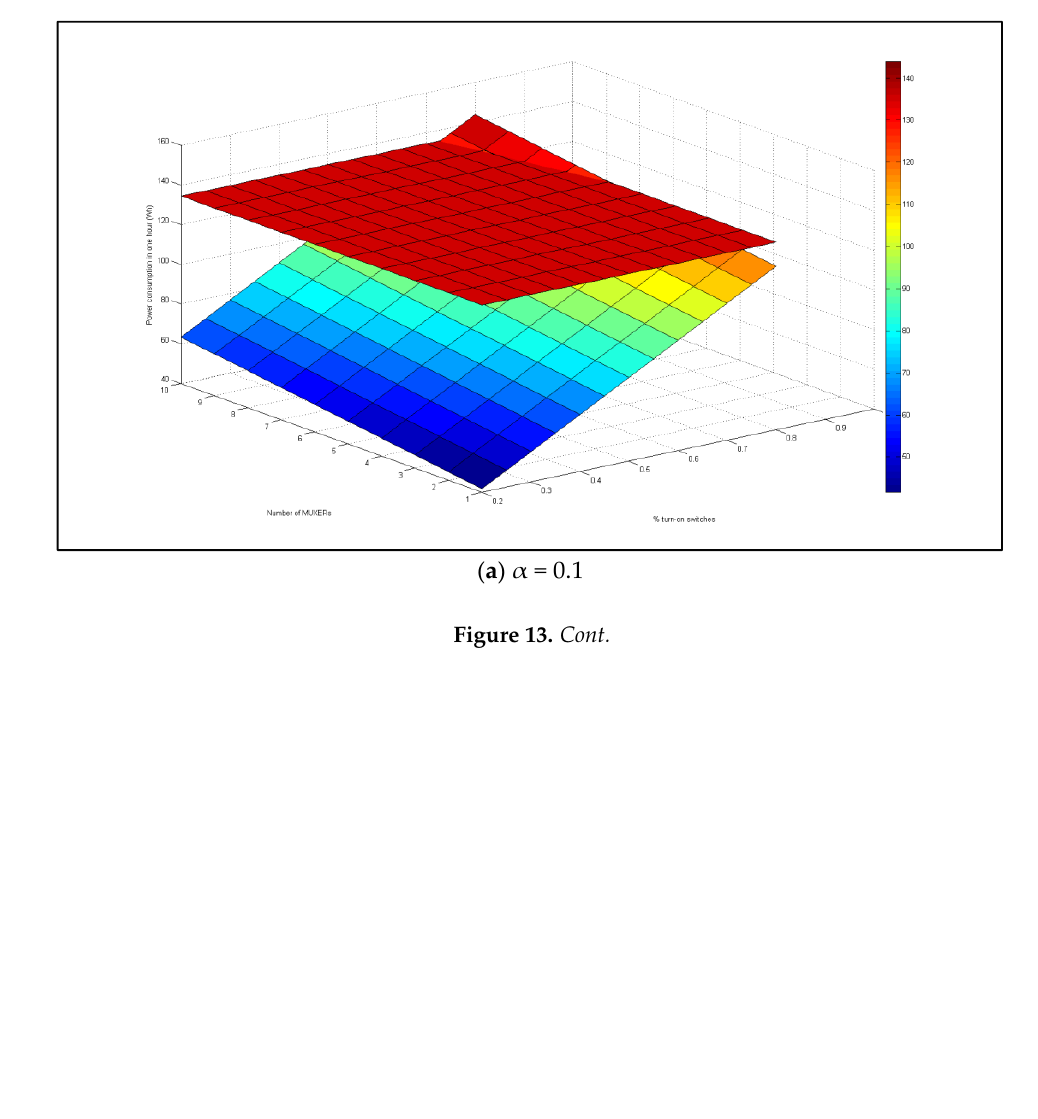
Figure 12. Power consumption results of model 1 and model 2 with n = 584 switches, and α = (0.1, 0.4, 0.6, 0.8). ( a ) α = 0.1; ( b ) α = 0.4; ( c ) α = 0.6; ( d ) α = 0.8.